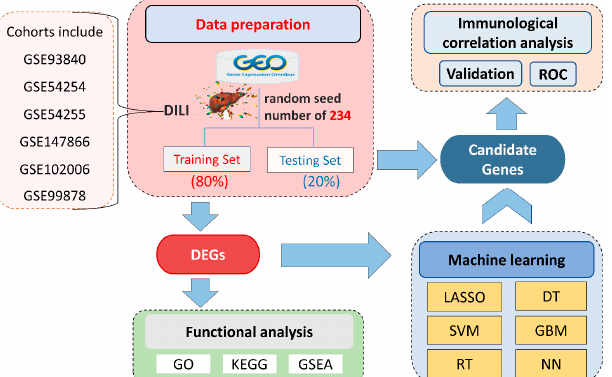
Figure 1. Illustration of the overall workflow. DILI, drug-induced liver injury; GEO, Gene Expression Omnibus; DEGs, differentially expressed genes; GO, gene ontology; KEGG, Kyoto Encyclope- dia of Genes and Genomes; GSEA, gene-set enrichment analysis; SVM, support vector machine; LASSO, least absolute shrinkage and selection operator; RT, random forest; GBM, gradient boost- ing machine; DT, decision tree; NN, neural network; ROC, receiver operating characteristic. 2.2. Identification of DEGs In the training set, we identified 21 biologically significant differentially expressed genes (DEGs), as detailed in Supplementary Table S2. A volcano plot showed that, com- pared with the control samples, all 21 DEGs were significantly upregulated in the DILI samples. Generally speaking, the larger the absolute value of Log FC and adjusted P value of − Log10, the greater the difference between the two groups. Therefore, growth arrest and DNA damage-inducible protein GADD45 α (GADD45A) and DNA damage-induci- ble transcript 3 protein (DDIT3) were distributed to the edges of the heatmap, indicating a clear difference between the two groups (Figure 2).